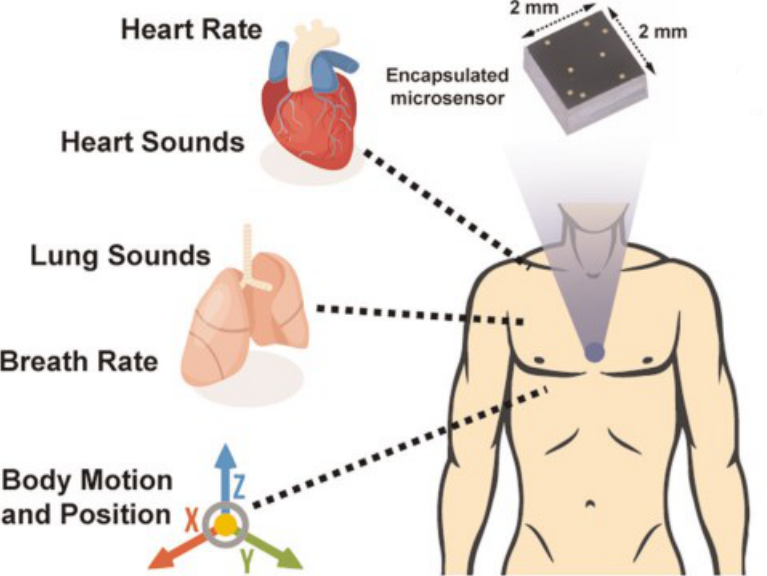
Figure 2. Use of ACM on the sternum to capture cardiopulmonary activity and sounds as well as body motion and position